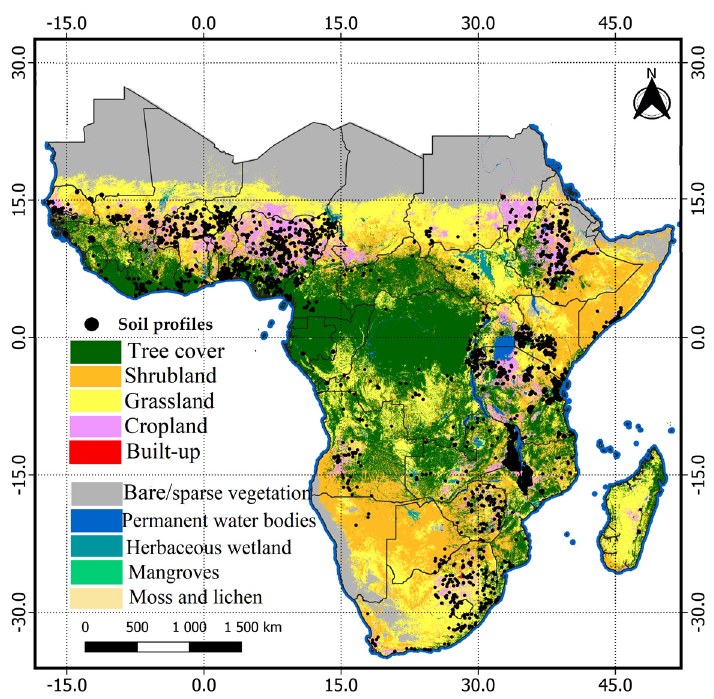
Figure 1. Distribution of soil profiles used in the evaluation and prediction of the soil acidity of SSA croplands. Soil profile data of SSA croplands were extracted from Soil Africa information services [34] and land use and cover data of sub-Saharan Africa were extracted from The European Space Agency (ESA) WorldCover 10 m 2020 product [35]. AfSIS refers to the Africa Soil Information